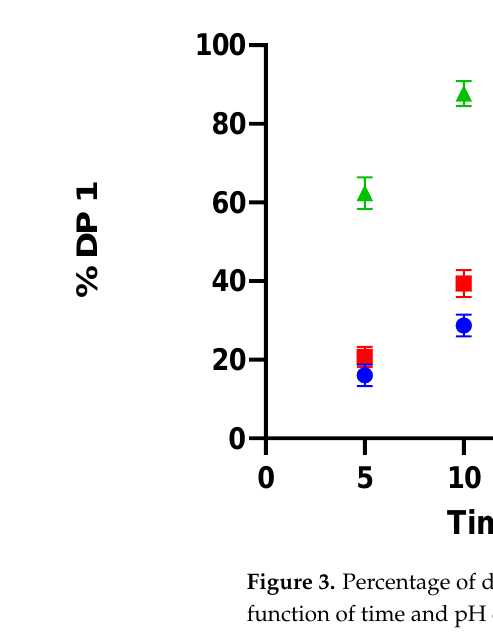
Figure 3. Percentage of degradation product formed under the simulated light condition (DP1) as a function of time and pH condition.